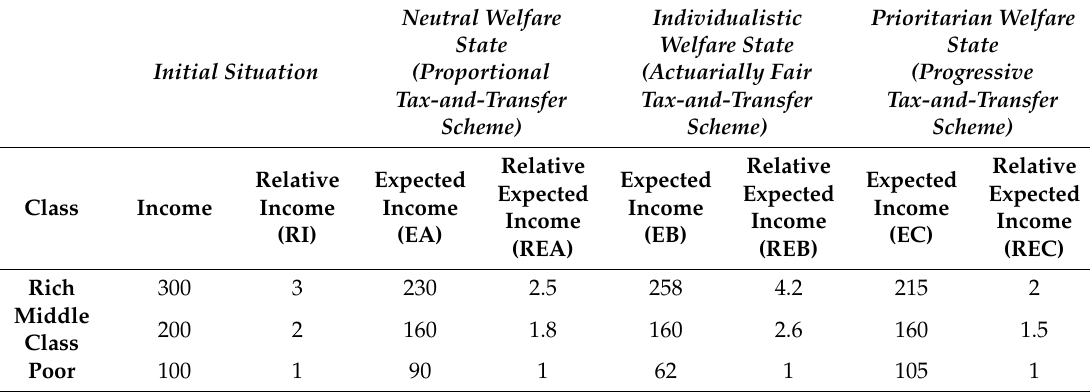
Table 1. The three Welfare State contracts and expected income